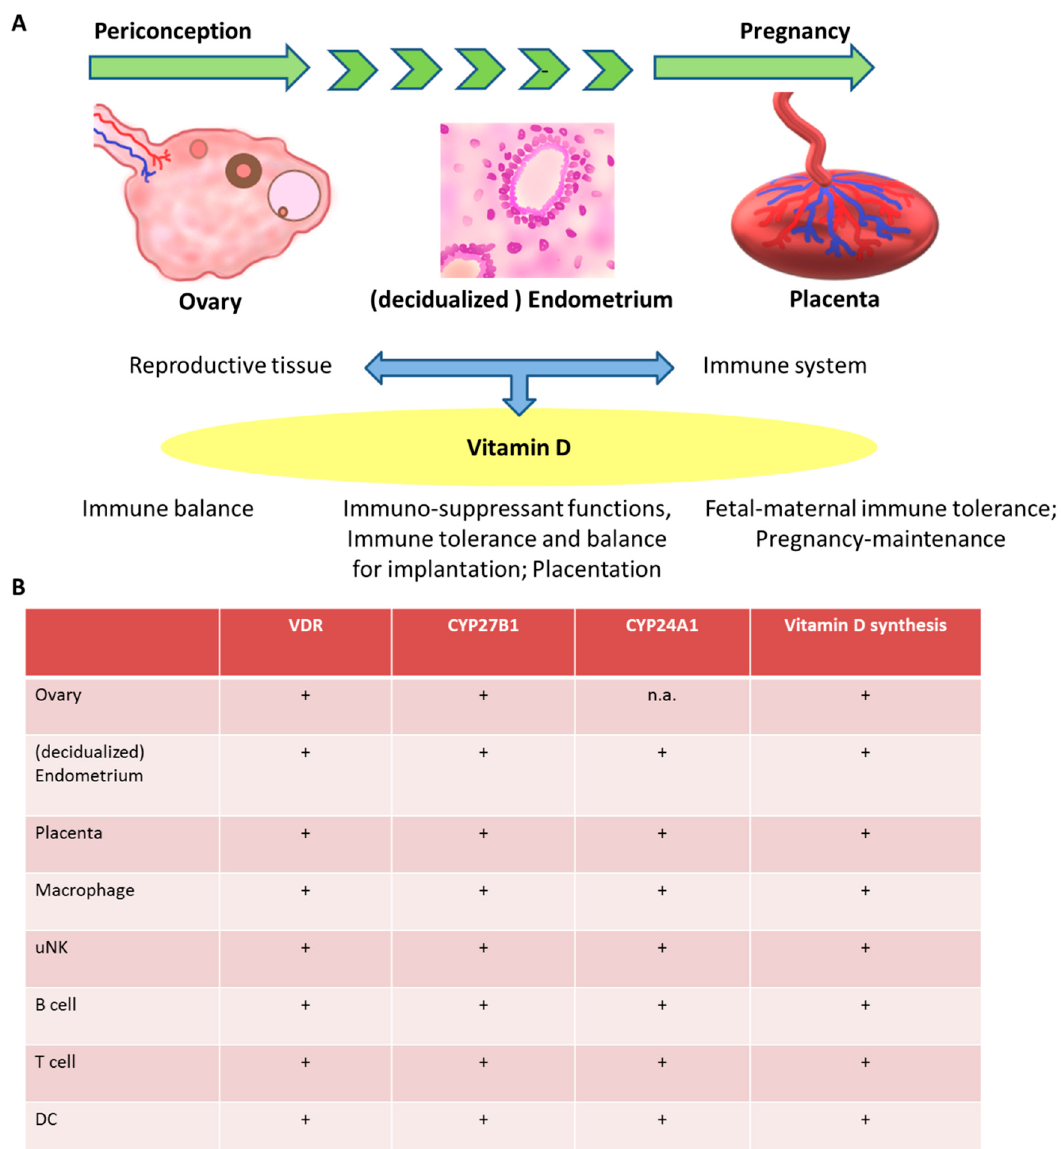
Figure 2. Components of vitamin D synthesis in female reproductive tissues and cells of the immune system. ( A ) Vitamin D exerts immunomodulatory e ff ects with impact on reproductive tissues from the periconception period throughout pregnancy. ( B ) Components of the vitamin D metabolic system are expressed in female reproductive tissues, including ovary, decidua, endometrium and placenta and multiple immune cells. Proposed immunomodulatory e ff ects of vitamin D include the improvement of immune balance, tolerance and maintenance of pregnancy trough e ff ects on B cells, T cells, macrophages and dendritic cells. + ; expression known, n.a.; not